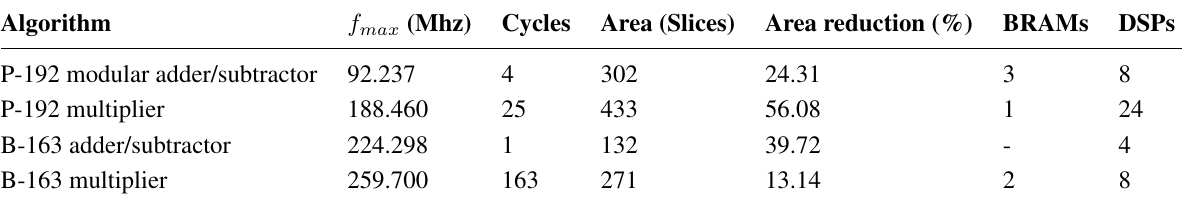
Table 4. PAR results of the cryptographic algorithms implemented only using DSPs